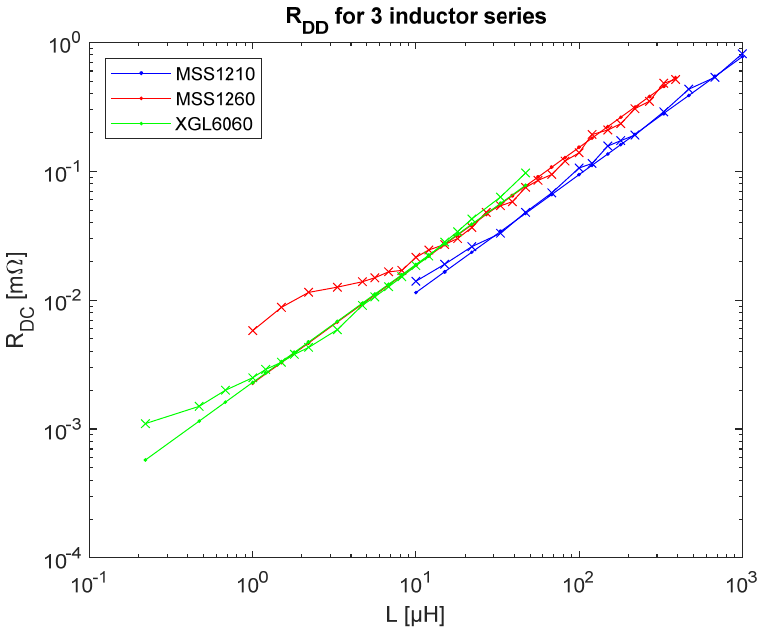
Figure 4. Evolution of the R DC series resistance of the inductors with respect to inductor value for the three studied inductor series [15–17]. Also linearized R DC curves for each inductor series with respect to inductor value.